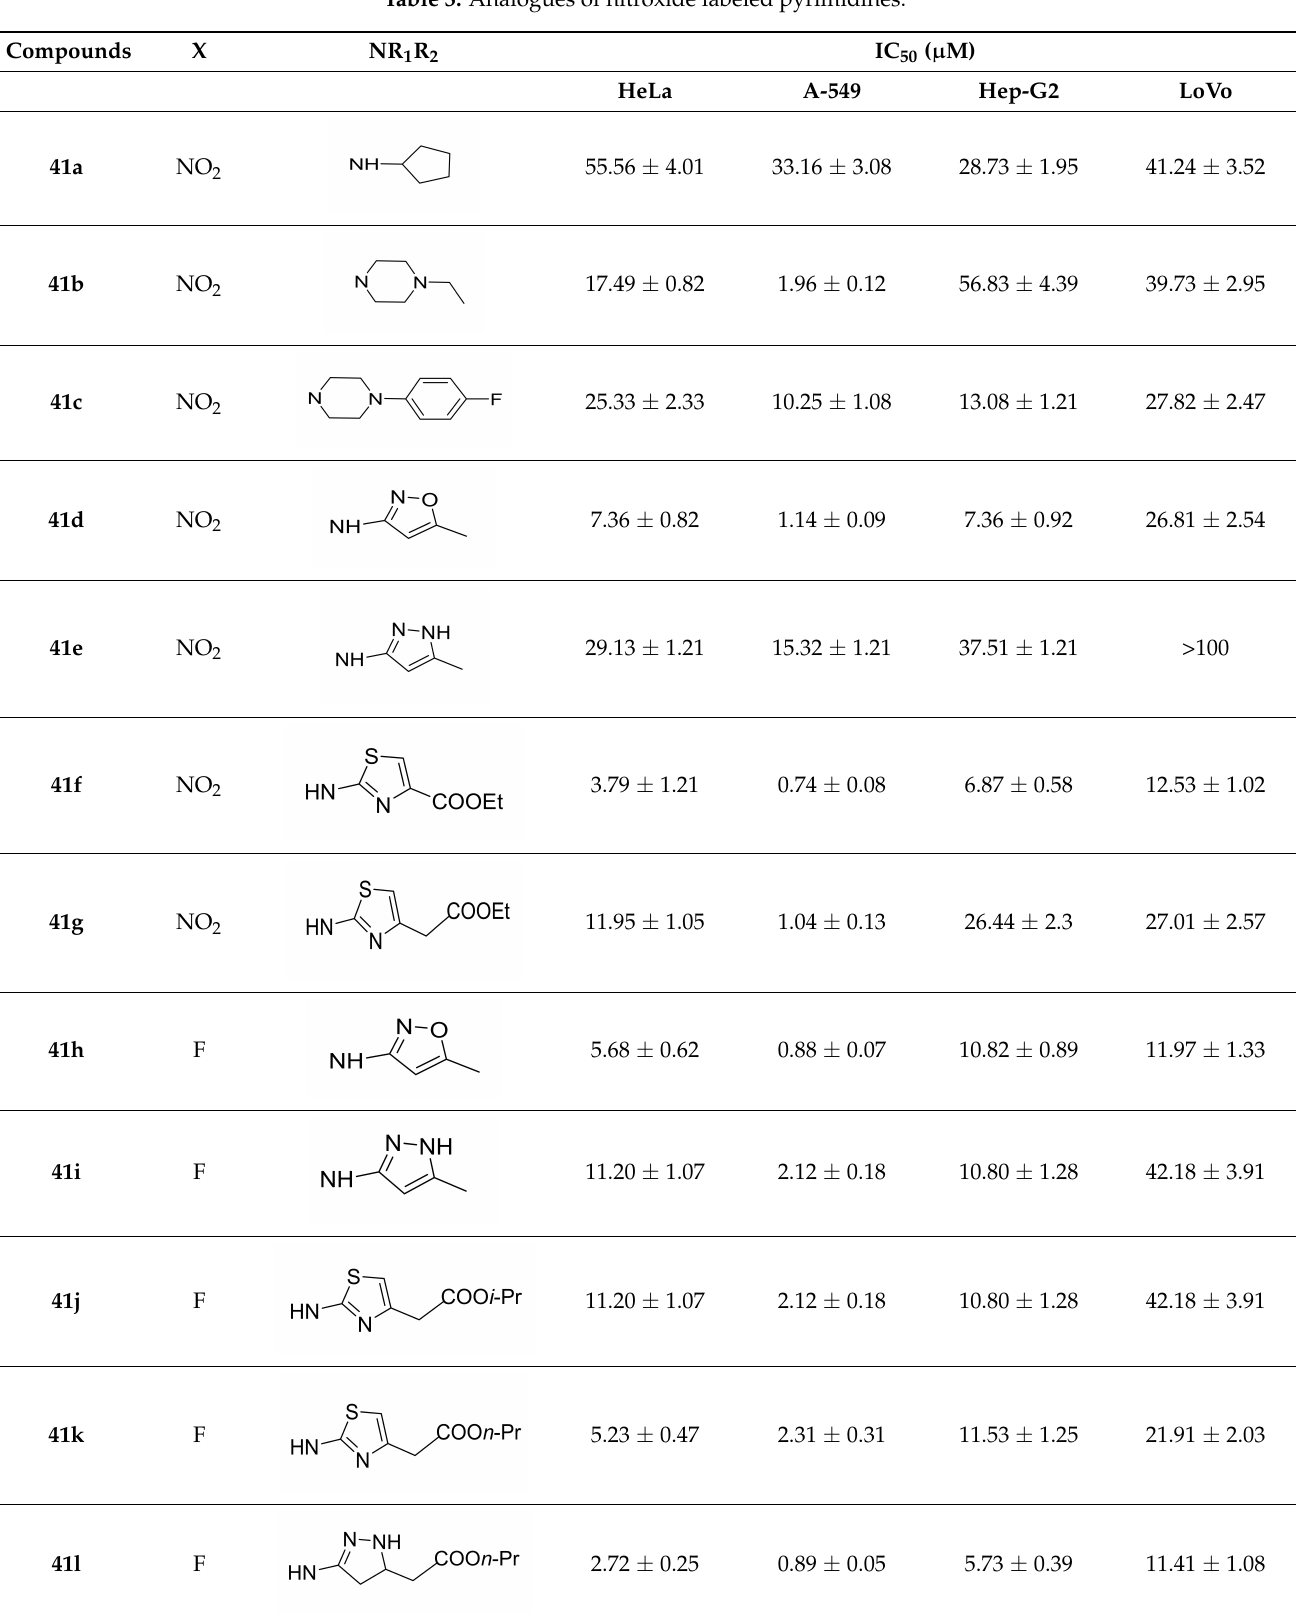
Table 3. Analogues of nitroxide labeled